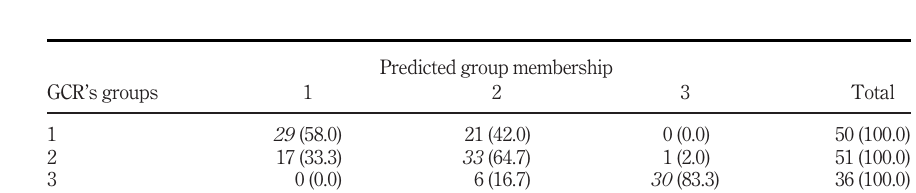
Table 6. Predictive analysis of discriminant